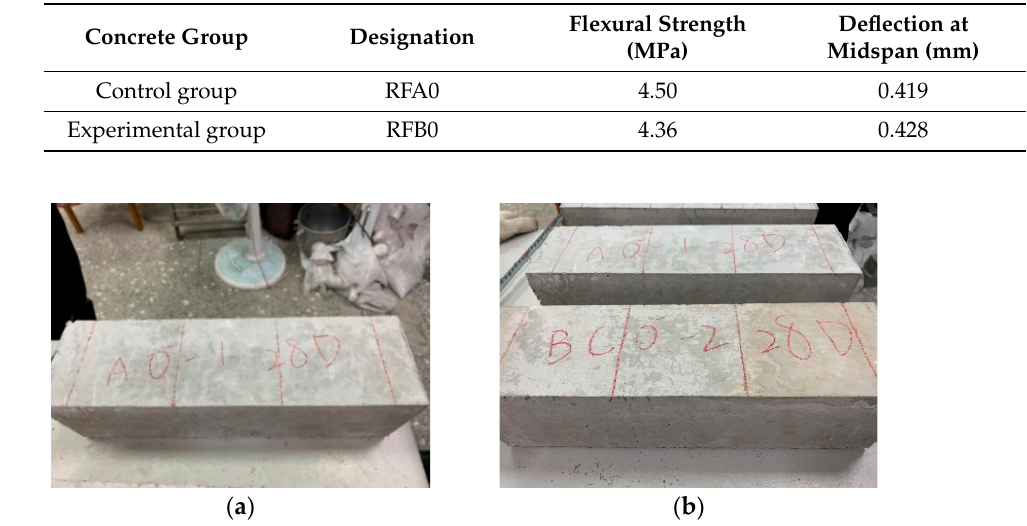
Table 18. Results of secondary flexural test of the flexural failure specimens after self-healing.